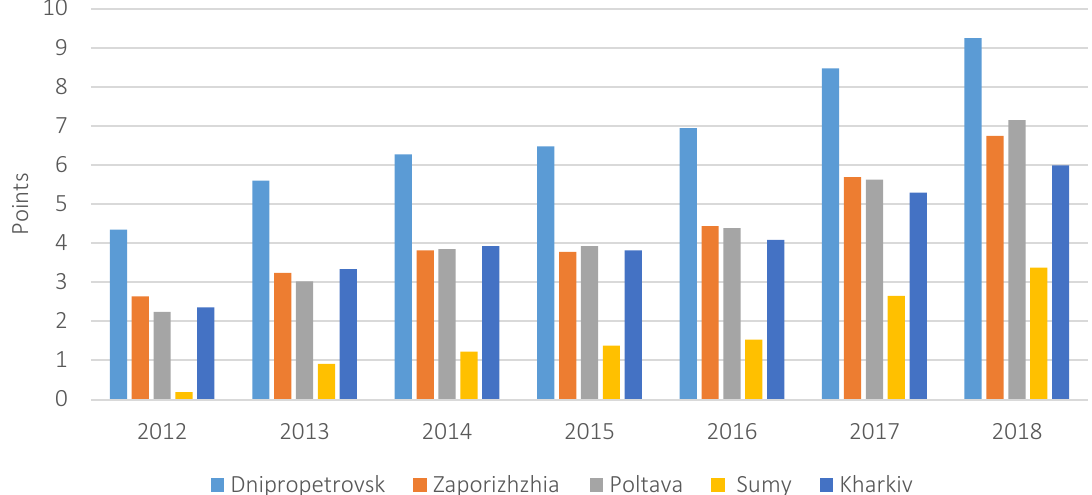
Figure 1. Integral index of level of economic development of